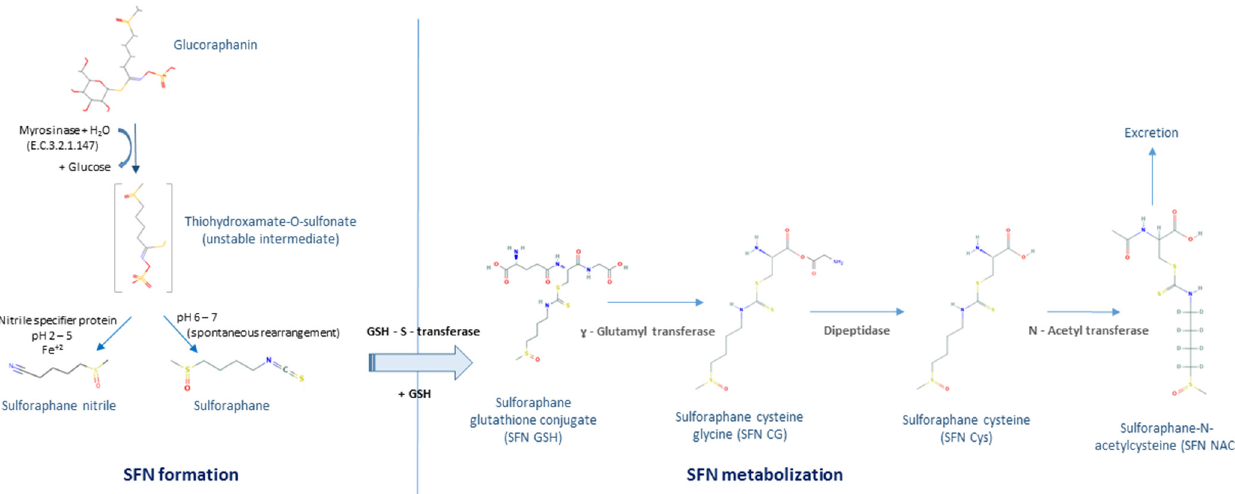
Figure 2. Formation and metabolization of sulforaphane. Sulforaphane (SFN) is formed by the hydrolysis of glucoraphanin catalyzed by either plant or bacterial myrosinase. After intake, SFN is metabolized through the mercapturic acid pathway. Initially, isothiocyanates are conjugated with glutathione (GSH) in a glutathione transferase (GST)-catalyzed reaction. Then, successive cleavage reactions catalyzed by γ -glutamyltranspeptidase, cysteinylglycinase, and N-acetyltransferase occur to generate sulforaphane-N-acetylcysteine (SFR-NAC) [8].